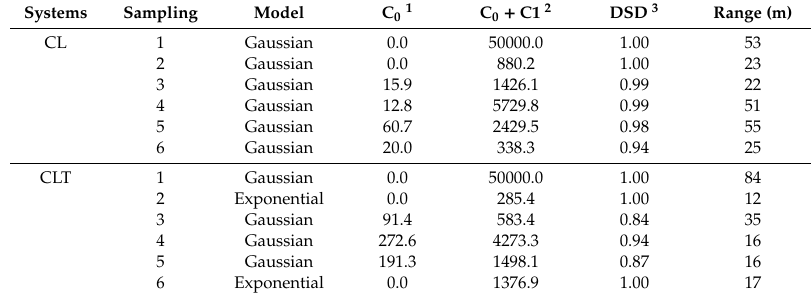
Table 4. Geostatistical models of the Thiessen areas in each sampling period, in the di ff erent integrated crop–livestock systems (CL, crop–livestock and CLT, crop–livestock–tree systems). Systems Sampling